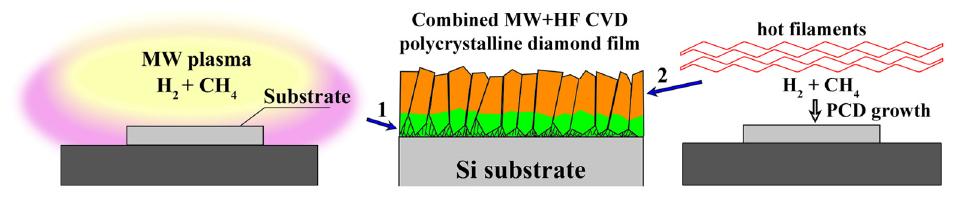
Figure 1. Scheme of the experiment.